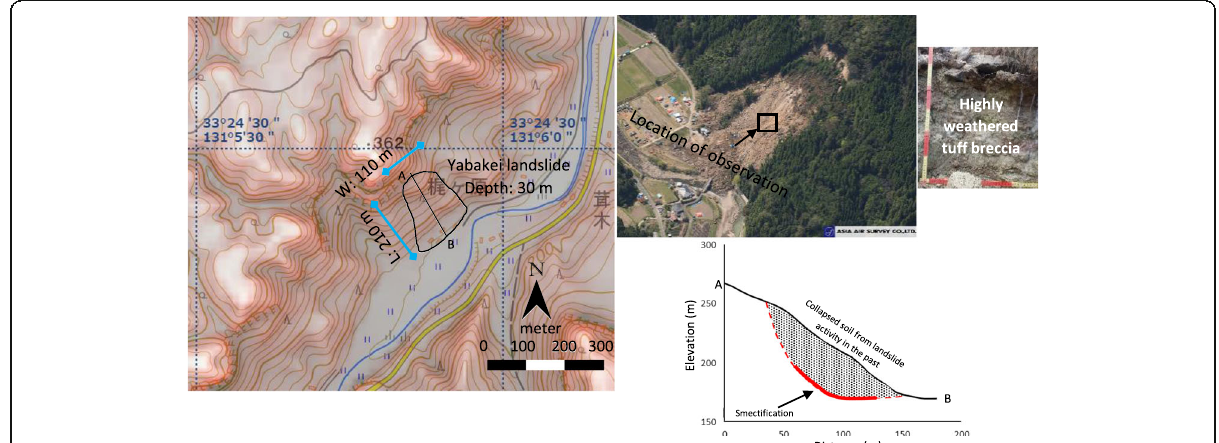
Fig. 8 Topographic map (Geospatial Information Authority of Japan 2020) with cross-section (modified Yabakei landslide investigation committee 2018), photo of slope from Asia Air Survey (2018), and photo of soil taken on July